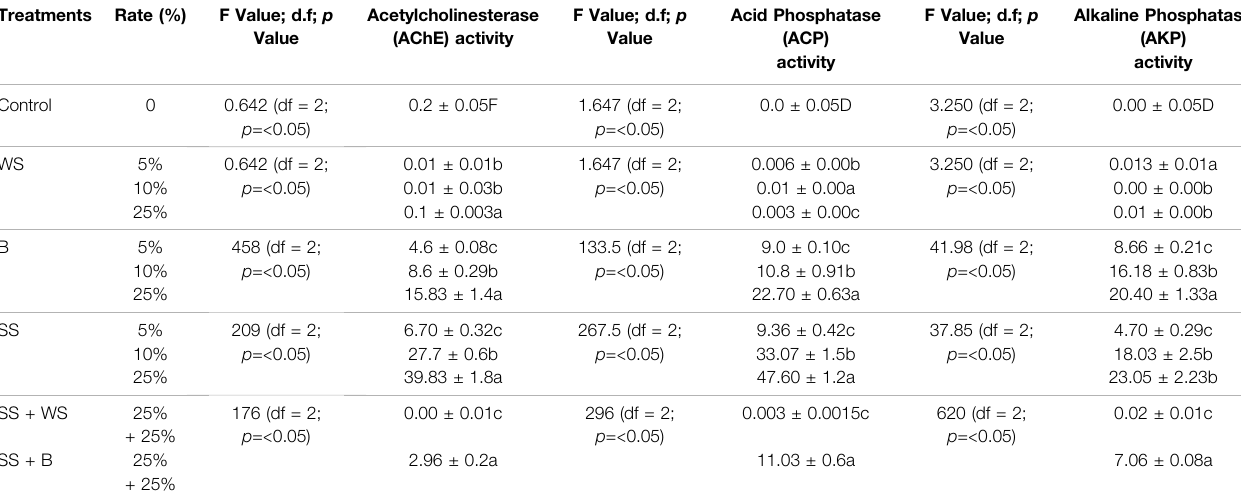
TABLE 2 | Percentage inhibition of different enzyme activities after exposure to different concentrations of soil amendments in Pheretima posthuma . Treatments Rate